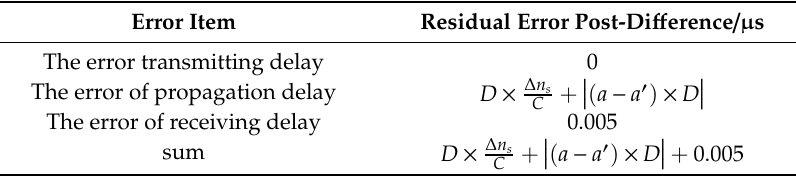
Table 4. Residual error after correction.